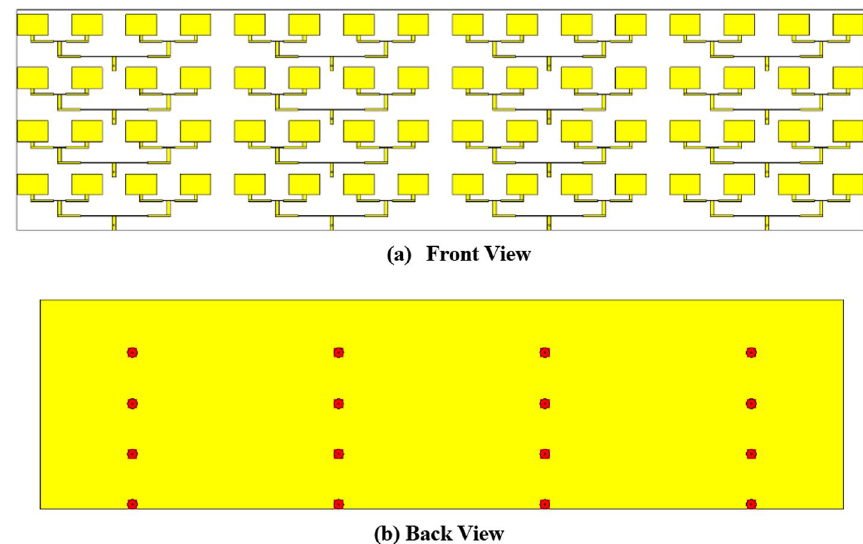
Fig. 2 Design of 8 8 massive MIMO antenna without DRA-EBG-DGS ×